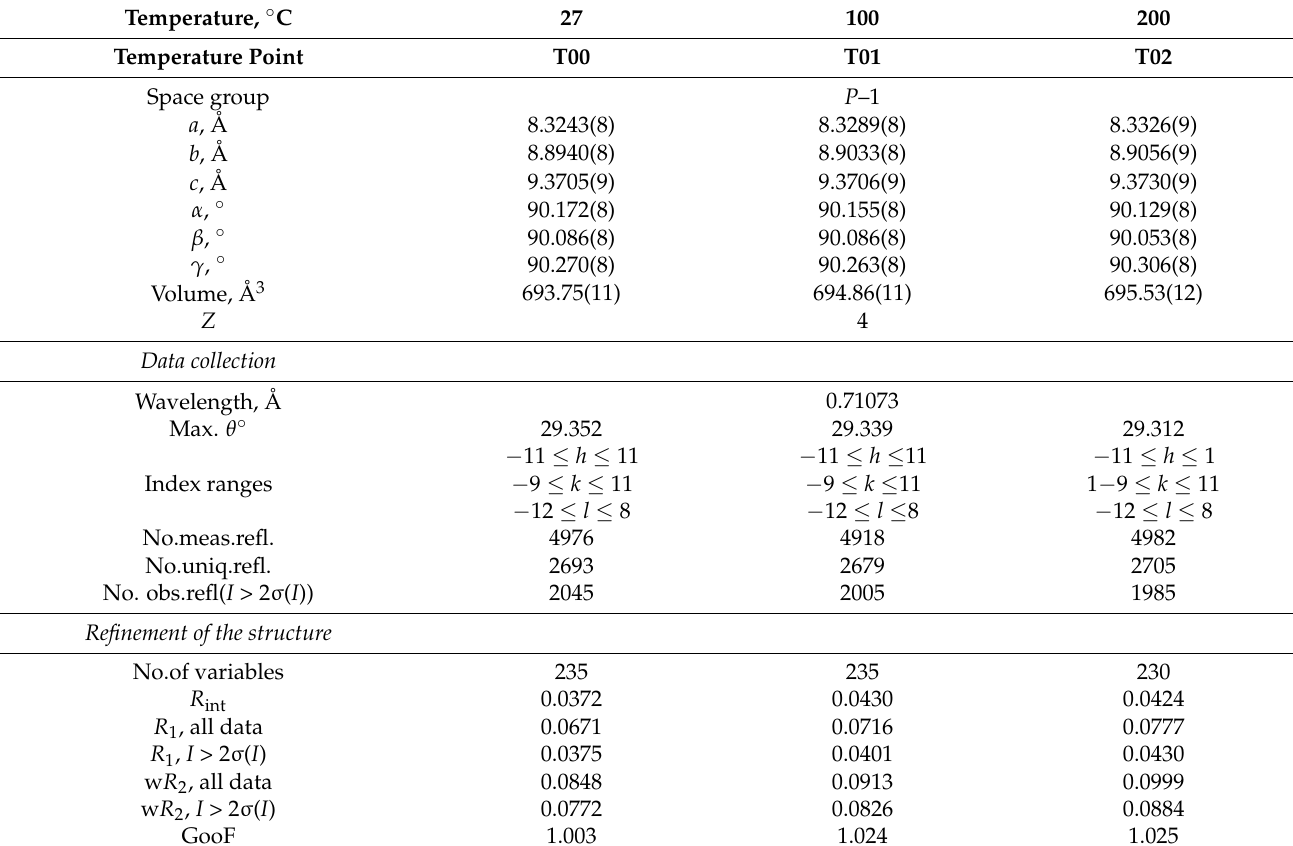
Table 2. Crystallographic data and refinement parameters for slawsonite SrAl 2 Si 2 O 8 at different temperatures in the P –1 space